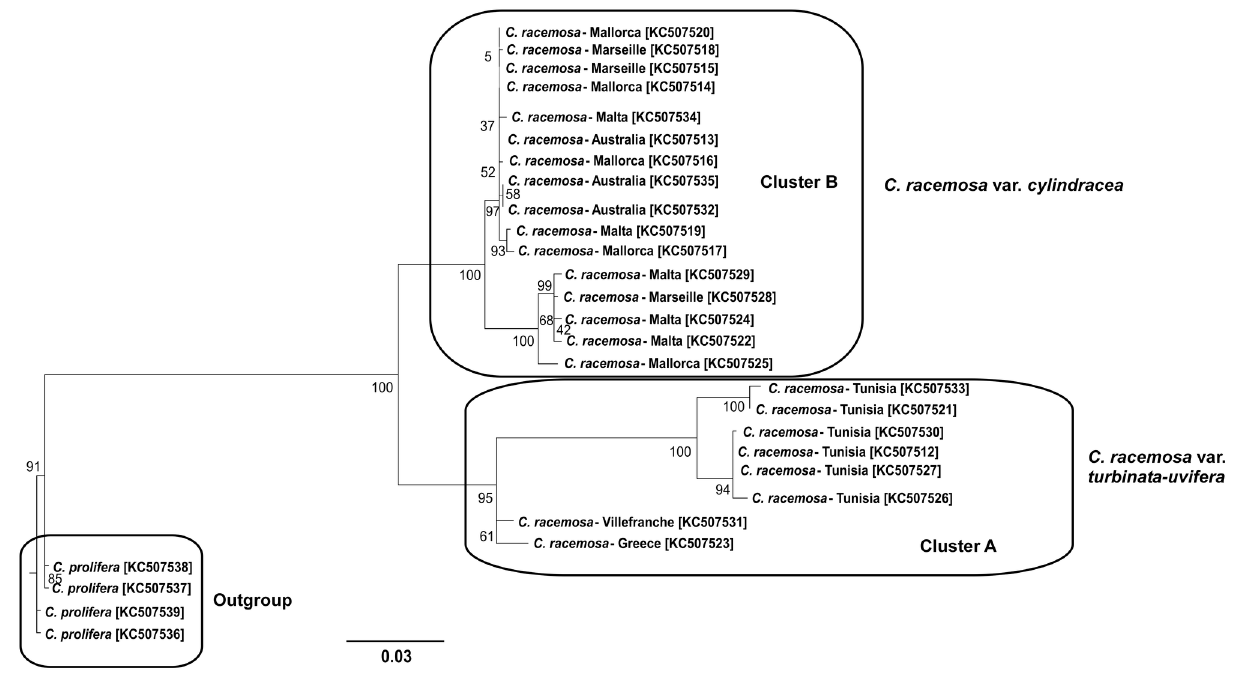
Figure 3. Maximum Likelihood tree from C. racemosa ITS calculated using the evolution Model TPM2+G with bootstraps calculated after 1000 replicates. . Alignments of each cluster were BLAST against Genebank nucleotide database and got the highest hits with sequences from Verlaque et al. 2003 study [AY334305-Cluster A and AY173118-Cluster B] C. prolifera samples from Mallorca were used as outgroup. Genbank accession numbers are represented within brackets.